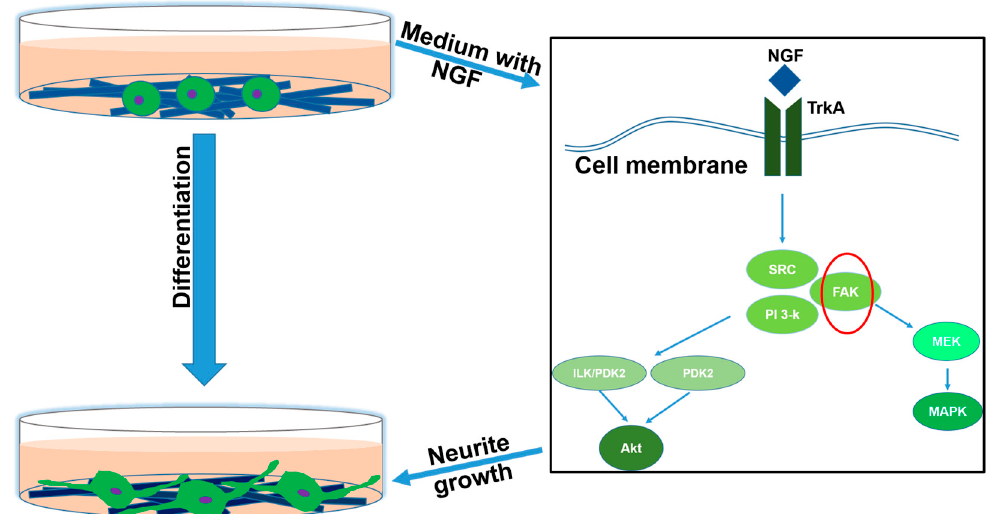
Figure 9. The schematic illustration of NGF induced differentiation and neurite growth of PC12 cells in this study. The combination of NGF and TrkA resulted in activation of Src and FAK, which resulted in the sustained activation of the downstream signaling. Activation of Akt downstream of PI 3-K is essential for neurite growth in this system. Additionally, signaling via MEK/MAPK may also leads to axonal extension. However, it is dispensable for neurite growth of NGF-responsive neurons.